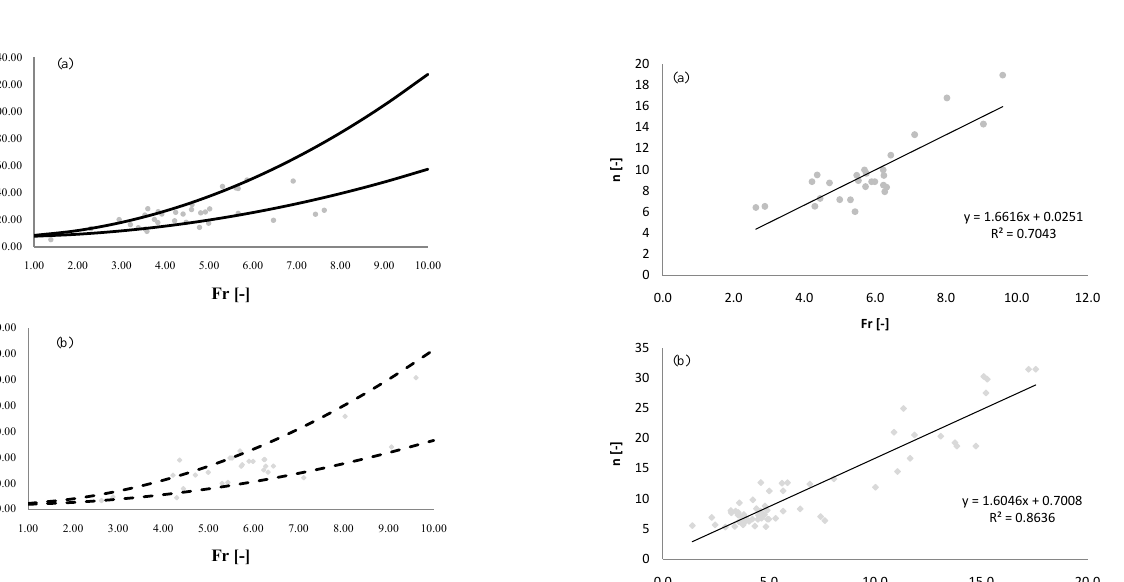
Figure 7. Dimensionless force vs. Froude number for flume inclina- tions equals to 30 ◦ (a) and 35 ◦ (b) : the points fall in a region derived by the proposed model using α = 1.2 (upper limit) and 0.5 (lower limit). The two regions are obtained using n = 9 (a) and n = 11 (b) .